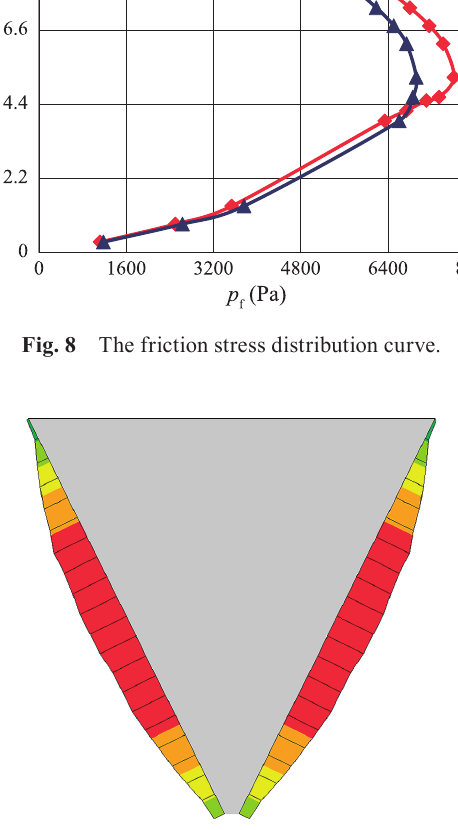
Fig. 9 The contact friction stress curve (on